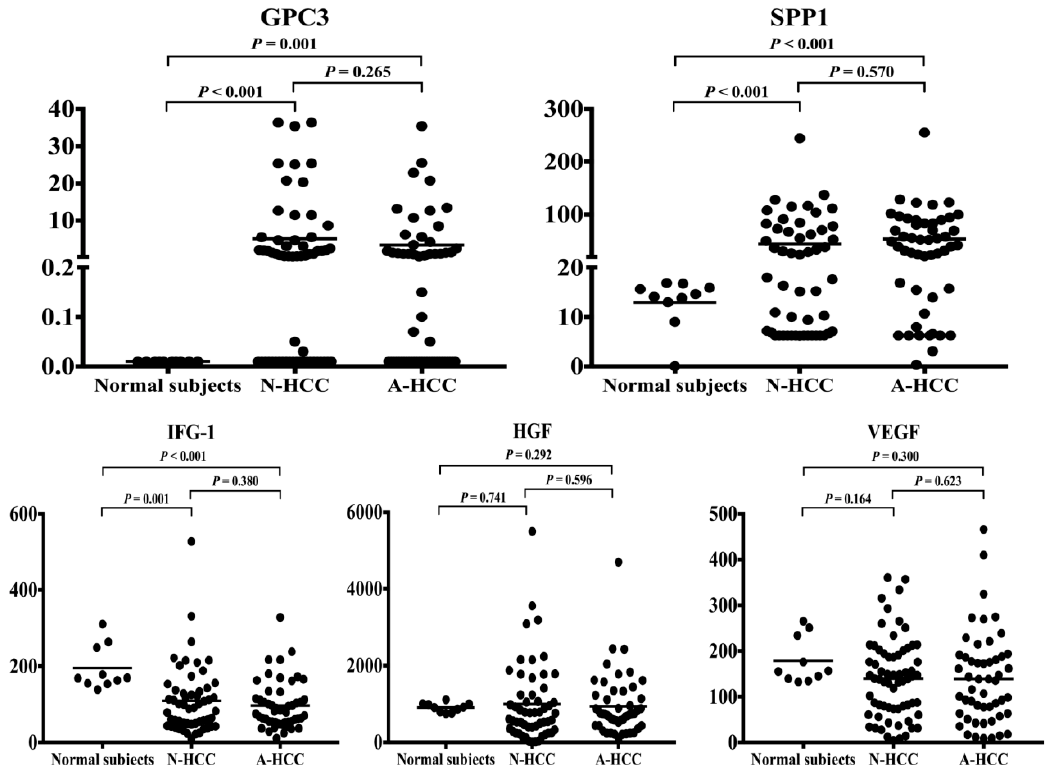
Figure 2. The scatter dot plots of GPC3, SPP1, IGF1, HGF, and VEGF. The serum levels of novel markers for N-HCC, A-HCC, and healthy subjects were determined by ELISA and represented as scatter dot plots. The arithmetic means of the tested parameters are indicated by a line. Student’s t test was employed for the statistical analysis and P < 0.05 was considered significant. GPC3, glypican 3; SPP1, secreted phosphoprotein 1; IGF1, insulin-like growth factor 1; HGF, hepatocyte growth factor; VEGF, vascular endothelial growth factor. N-HCC, normal α -fetoprotein HCC; A-HCC, abnormal α -fetoprotein HCC; ELISA, enzyme-linked immunosorbent